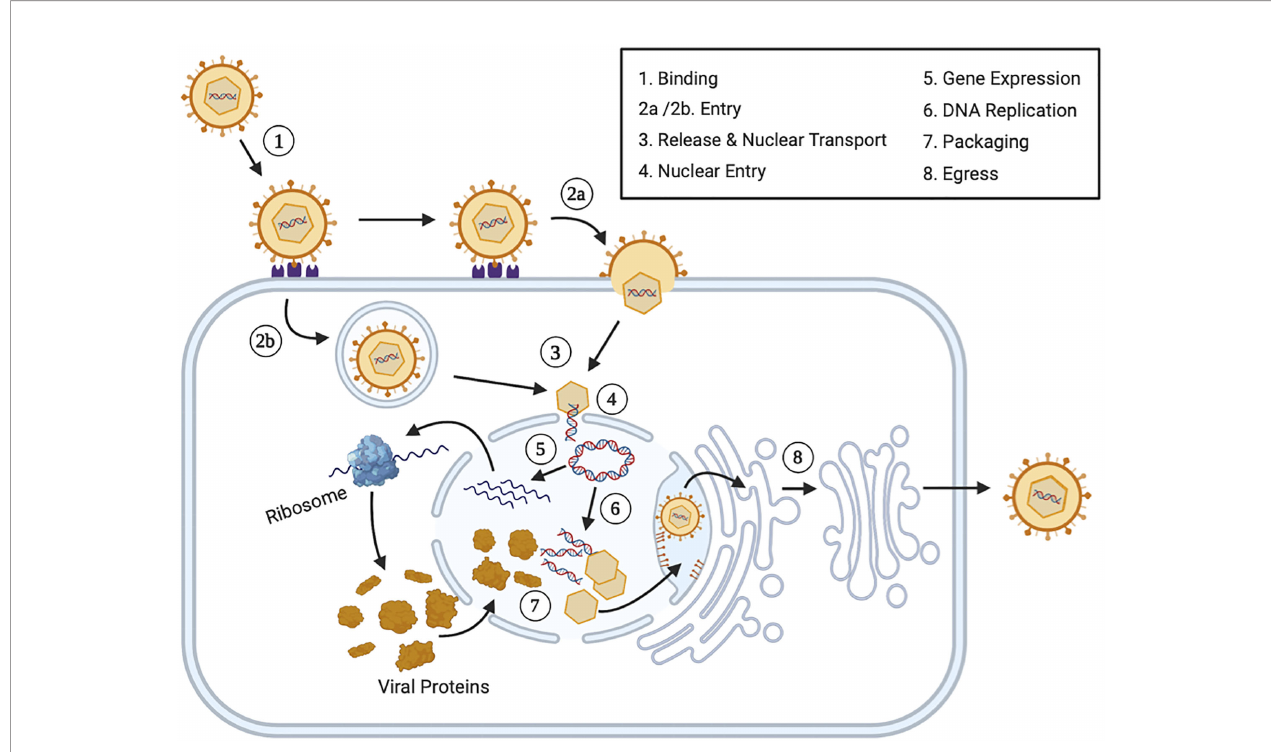
FIGURE 1 | The Lytic Human Herpesvirus Life Cycle. Step 1 ( Binding ): During primary lytic infection, HHVs bind extracellular host cells receptors using speci fi c envelope viral glycoproteins. Step 2 ( Entry ): HHVs enters the cell via fusion through receptor mediated endocytosis (2a) or endosome formation (2b). Step 3 ( Release and Nuclear Transport ): After viral uncoating, both the nucleocapsid and tegument proteins are released into the cytoplasm. The nucleocapsids are transported via cytoskeletal structures or diffusion to the nucleus. Step 4 ( Nuclear Entry ): The viral genome plus some associated viral proteins, including some tegument proteins, enter the nucleus via nuclear pores and the viral genome circularizes. Step 5 ( Gene Expression ): Immediately early (IE) viral genes, early (E) viral genes and late (L) viral genes are expressed in a temporal fashion. Each set of mRNAs are transported to the cytoplasm and translated into protein before returning to the nucleus and before initiating the next set of viral genes. Step 6 ( DNA Replication ): Early viral gene expression initiates viral DNA replication. Step 7 ( Packaging ): Late viral structural proteins assemble into viral capsids and they are packaged with DNA. Step 8 ( Egress ): Viral progeny bud through the inner nuclear membrane and enter the intermembrane space. Virions are transported to the nuclear associated endoplasmic reticulum and are transported to the cellular plasma membrane, where they are released via cell fusion, exocytosis or cellular